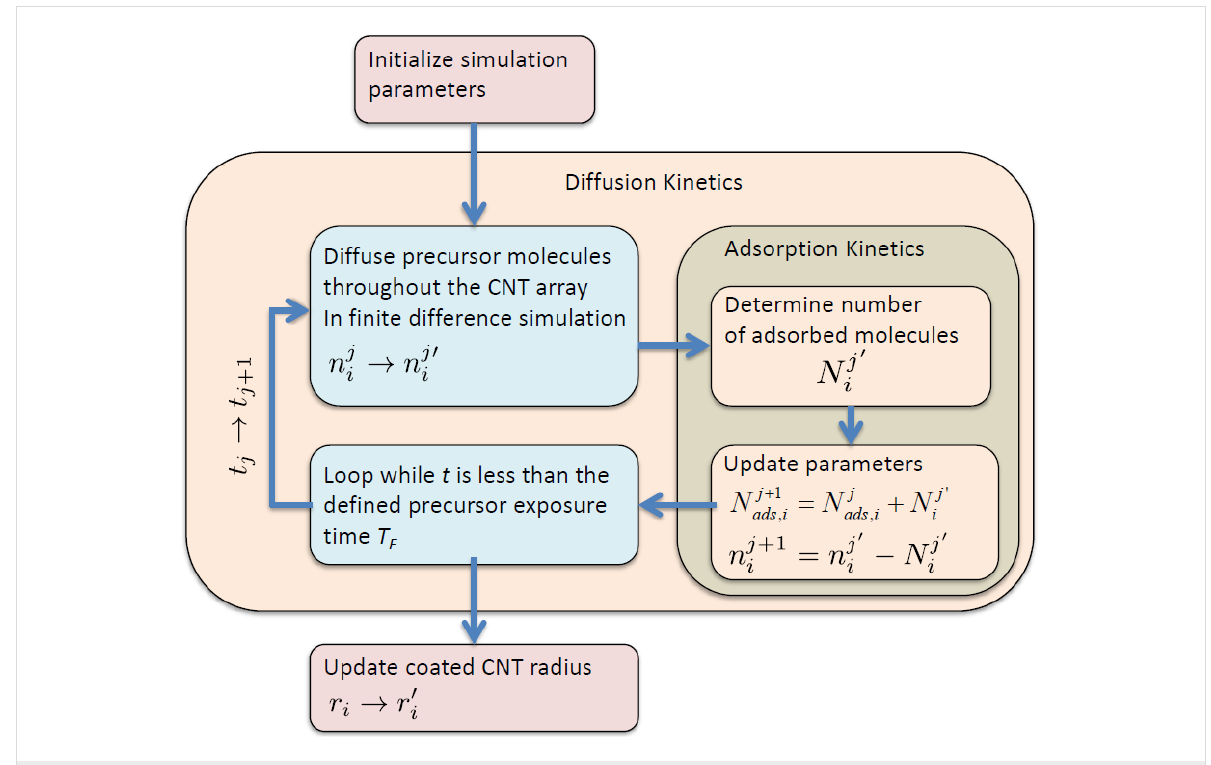
Figure 2: Flow chart of the precursor exposure/adsorption simulation for one ALD